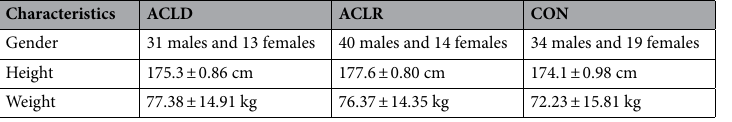
Table 4. Subjects’